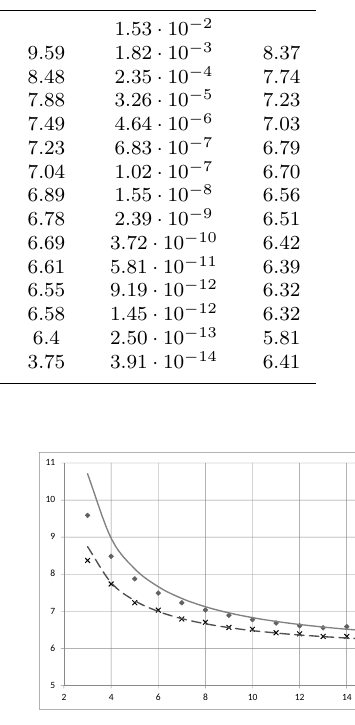
Table 1. Errors and ratios of errors for equation (6.1) with α = 3 / 2 and α = 1 / 2. N error ( α = 3 / 2) ratio error ( α = 1 / 2) ratio